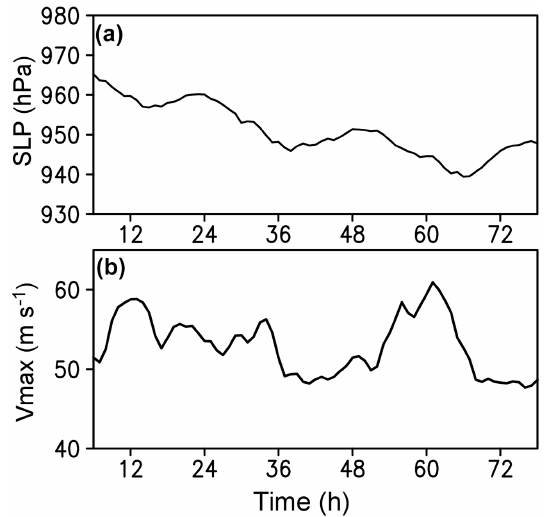
Figure 2. Time series of tropical cyclone intensity: (a) sea level minimum pressure (hPa) and (b) maximum wind speed at 10m (ms − 1 )